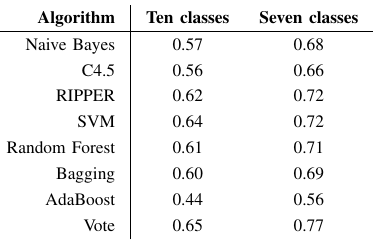
TABLE II: Confusion matrix of the Vote classifier on the